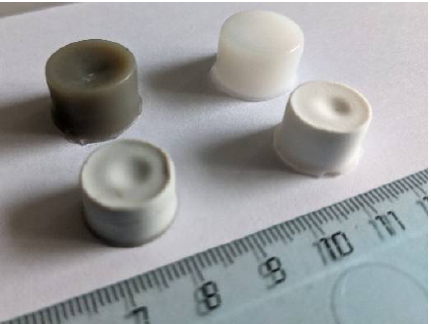
Figure 2. Digital photo of the prepared cellulose hydrogels (top row) and aerogels (bottom row). The equilibrium water content in the hydrogels was 91.4 ± 0.2% and 91.5 ± 0.1% for the hydrogel based on MCC and Ag-MCC composite hydrogel, respectively. When changing solvents from water to methanol, no significant shrinkage was observed, while after supercritical drying of the gels, shrinkage was around 20 vol.%. The presence of metal did not affect the shrinkage